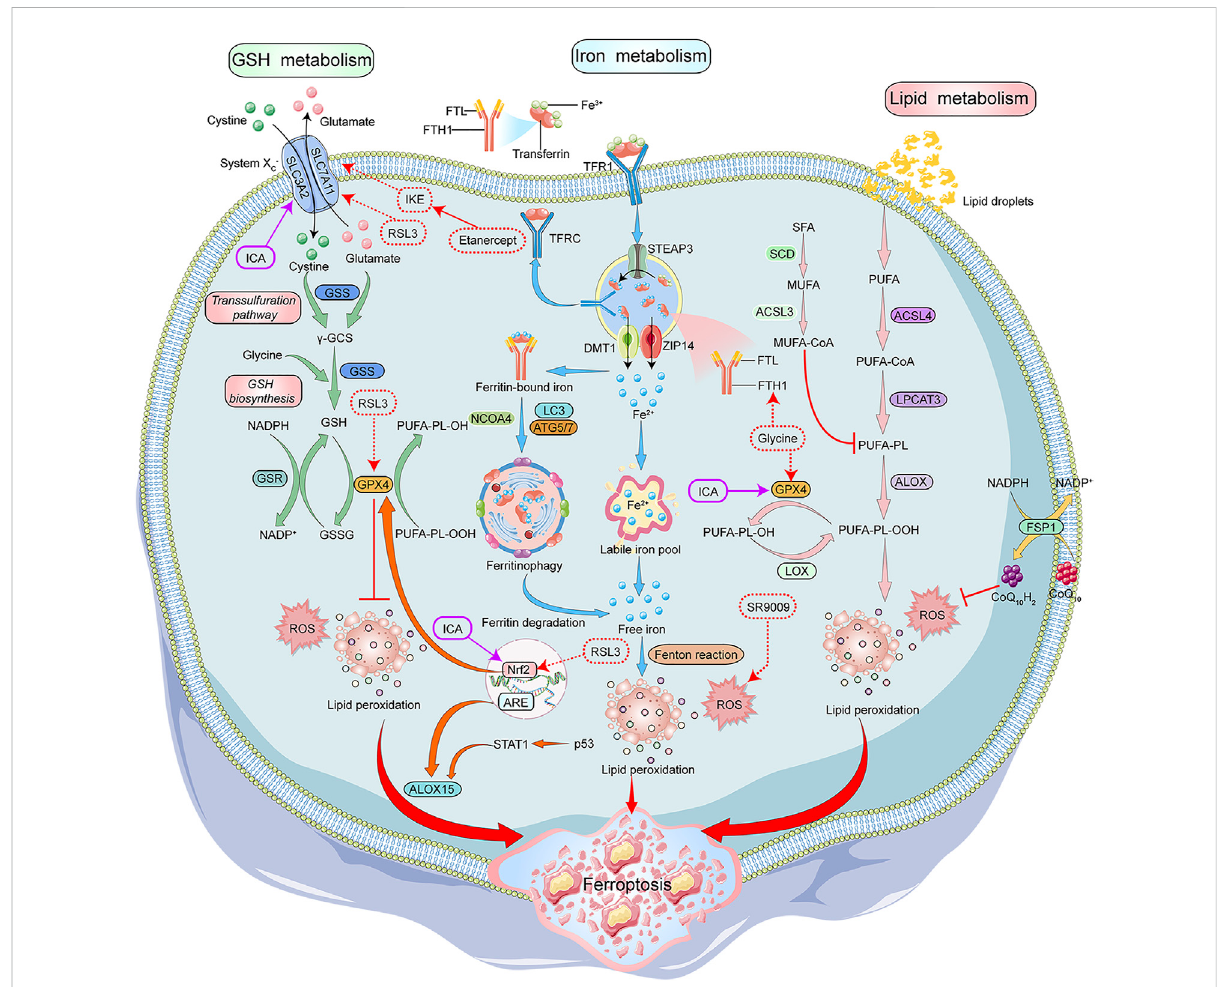
FIGURE 2 Mechanisms of Ferroptosis andits modulatorsinRA treatment. GSH, ironand lipid metabolism are thecore components of ferroptosis. System Xc-/GPX4axisisimportantforGSHsynthesis.SystemXc-transportscystineintothecellstogenerate γ -GCSalongwithglutamate,whichiscatalyzed byGSS.GSHissynthesizedby γ -GCSandglycine.GSHactsasaGPX4cofactortoconvertPUFAs-OOHtoPUFAs-OH.STEAP3convertedFe 3+ toFe 2+ in the endosomes, and the In fl ux of Fe 2+ into the cytoplasm is mediated by DMT1 or ZIP14. In the cytoplasm, a small portion of Fe 2+ remains in the LIP, and most of Fe 2+ combines with ferritin for storage. NCOA4 aids in the autophagy of ferritin to provide Fe 2+ by inducing ferritin degradation. The intracellular PUFAs-OOH reacts with Fe 2+ to induce lipid peroxidation, eventually leading to ferroptosis. ALOX15 promotes lipid peroxidation, and CoQ 10 H 2 inhibits lipid peroxidation. NADPH/FSP1/CoQ10 pathway is an antioxidant pathway parallel to GPX4. Glycine, SR9009, RSL3, and etanercept show positive effects on the treatment of RA patients by inducing ferroptosis, while G1dP3 plays a positive role in RA treatment by inhibiting ferroptosis. GSH:glutathione, System Xc-:glutamate reverse transporter, GPX4:glutathione peroxidase 4, γ -GCS: γ -glutamylcysteine synthetase, GSS:glutathione synthetase, PUFAs:Polyunsaturated fatty acids, STEAP3:Six-Transmembrane Epithelial Antigen of Prostate 3, DMT1: divalent metal ion transporter 1, ZIP14:ZRT- and IRT-like protein 14, LIP:labile iron pool, NCOA4:nuclear receptor coactivator 4, ALOX15: arachidonate lipoxygenase 15, CoQ 10 H 2 :Ubiquinol-10, FSP1:ferroptosis suppressor protein 1, CoQ10:coenzyme Q10,